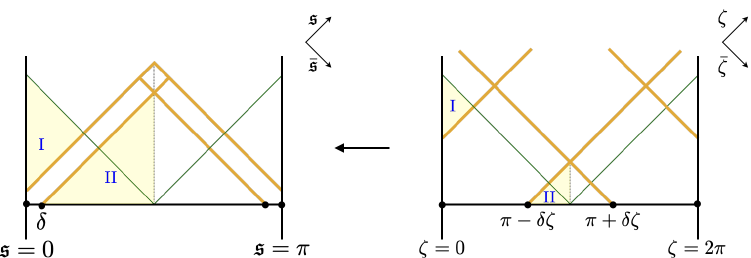
Figure 12. The map between the Lorentzian ζ and s cylinders. The regions marked I, II are the far-from-quench regions that will be relevant to us; they map to each other and their coordinate extents are given in equation (5.23). The regions between the orange lines are the near-quench regions; as can be seen the near-quench region is the majority of the ζ